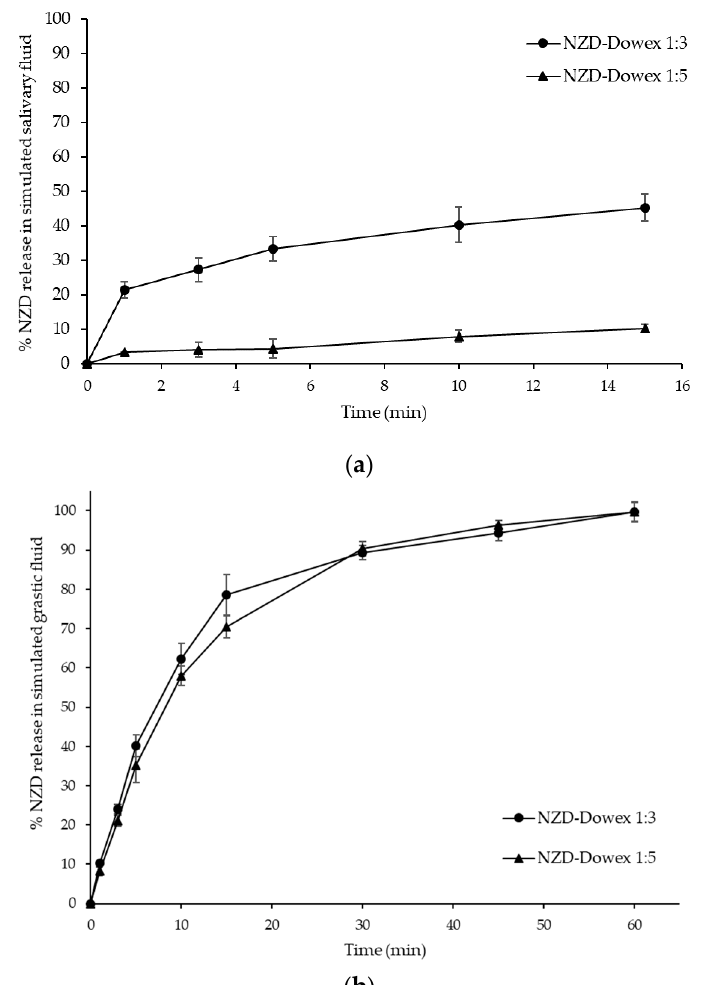
Figure 5. Dissolution profiles of the NZD-Dowex complex at 1:3 and 1:5 ratios (n = 6) in simulated salivary fluid of pH 6.8 (a) and gastric fluid of pH 1.2 (b) at different time intervals.